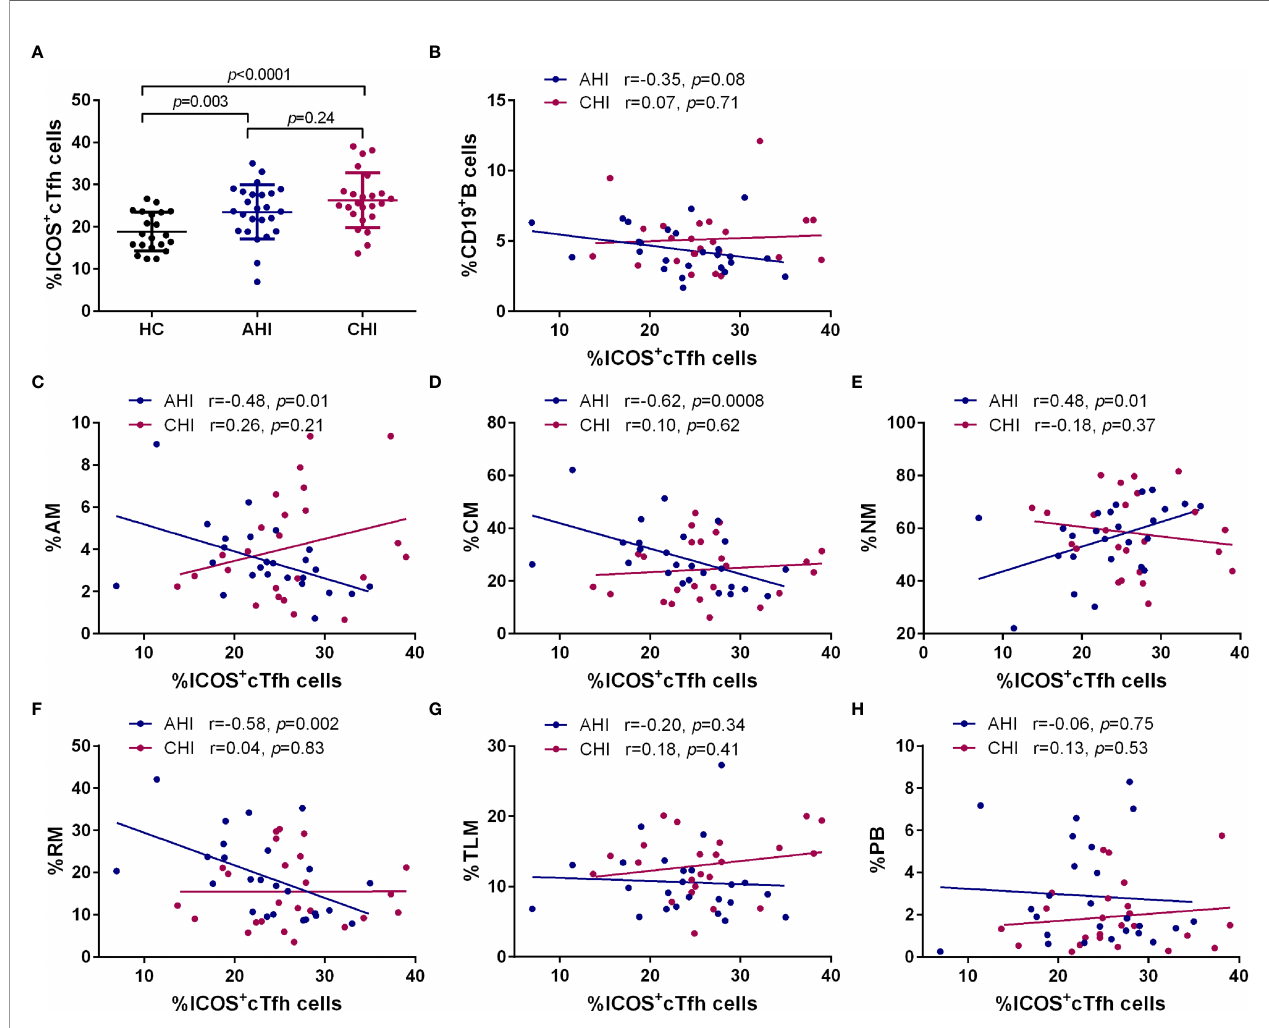
FIGURE 3 | Correlation between the frequencies of B cell subsets and ICOS + cTfh cells in the AHI and CHI groups. (A) . The frequency of ICOS + cTfh cells between HC (n=21), AHI (n=25), and CHI (n=25). All data shown are means ± SD. (B – H) . Correlation analysis of the ICOS + cTfh cell frequency with bulk B cells, AM, CM, NM, RM, TLM, and PB in the AHI and CHI